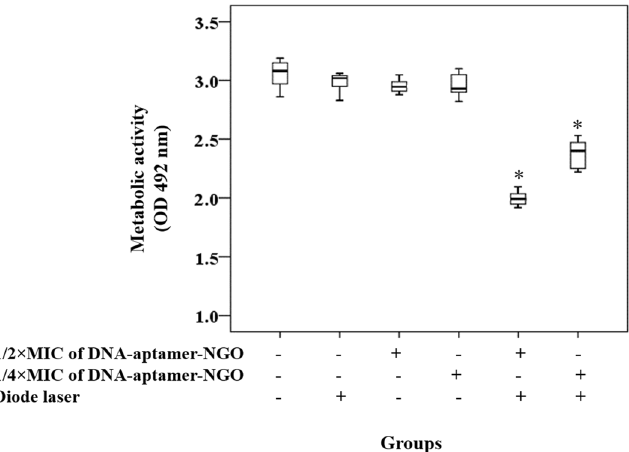
Figure 13. Anti-metabolic effects of different treatment groups against P. gingivalis. Metabolic reduction of P. gingivalis following treatment with 1/2 × and 1/4 × MIC of DNA-aptamer-NGO, aPDT (DNA-aptamer-NGO at 1/2 × and 1/4 × MIC plus diode laser), and diode laser were determined using the XTT (2,3-bis [2-methyloxy-4- nitro-5-sulfophenyl]-2H-tetrazolium-5-carboxanilide) reduction assay. Significant differences according to the control, * P < 0.05